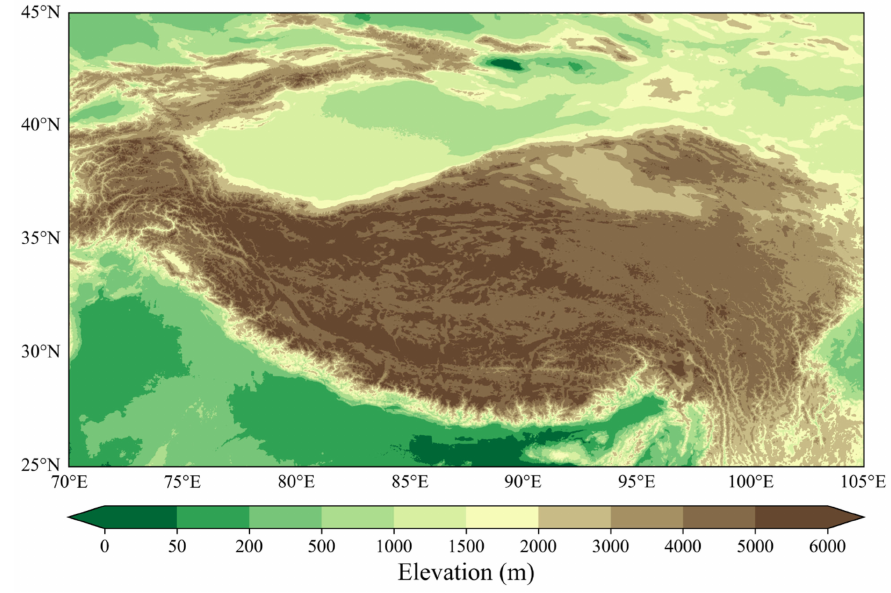
Figure 1. Topographical map of the study